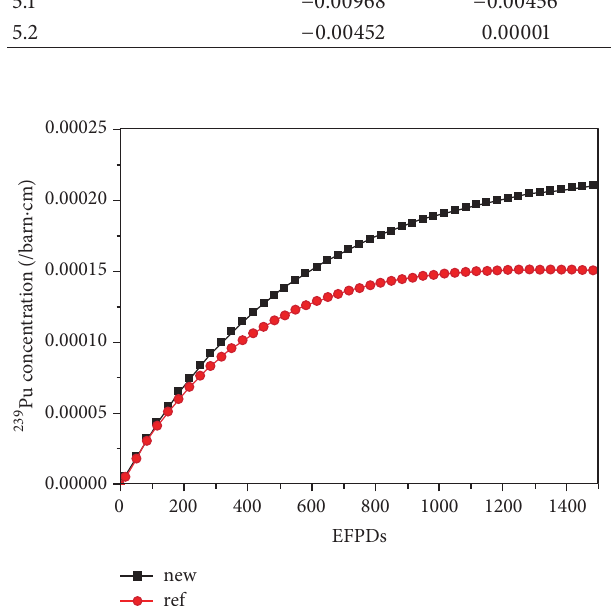
Figure 4: Concentration of 239 Pu versus EFPDs. Figure 5: Concentration of 235 U and equivalent fissile isotopic versus